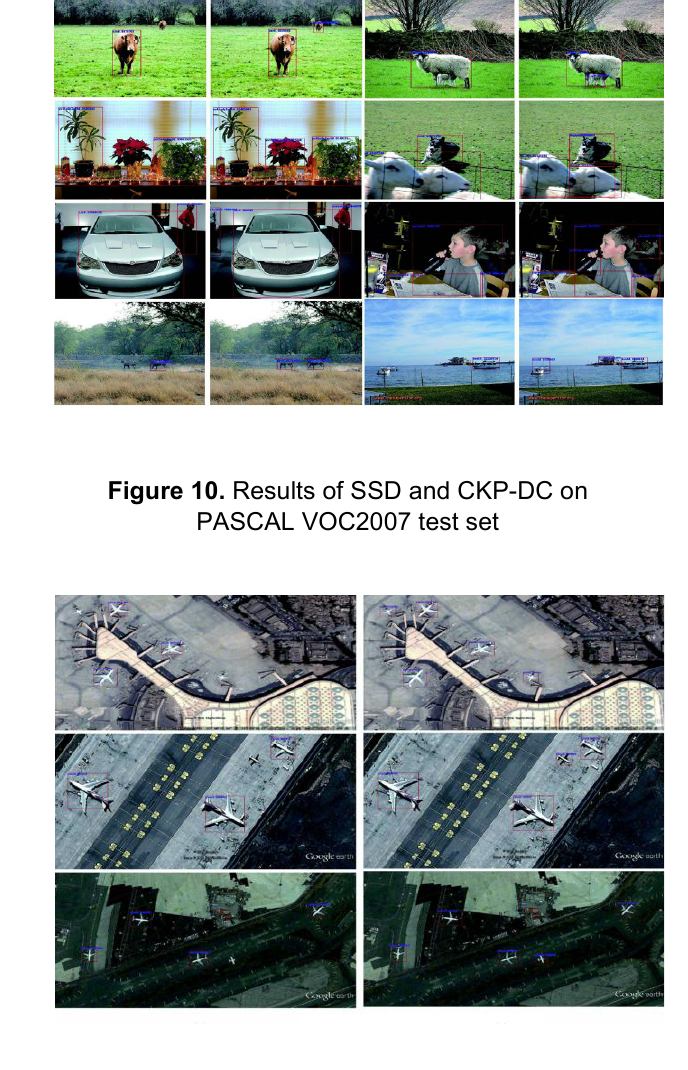
Figure 11. Results of SSD and CKP-DC in UCAS- AOD dataset